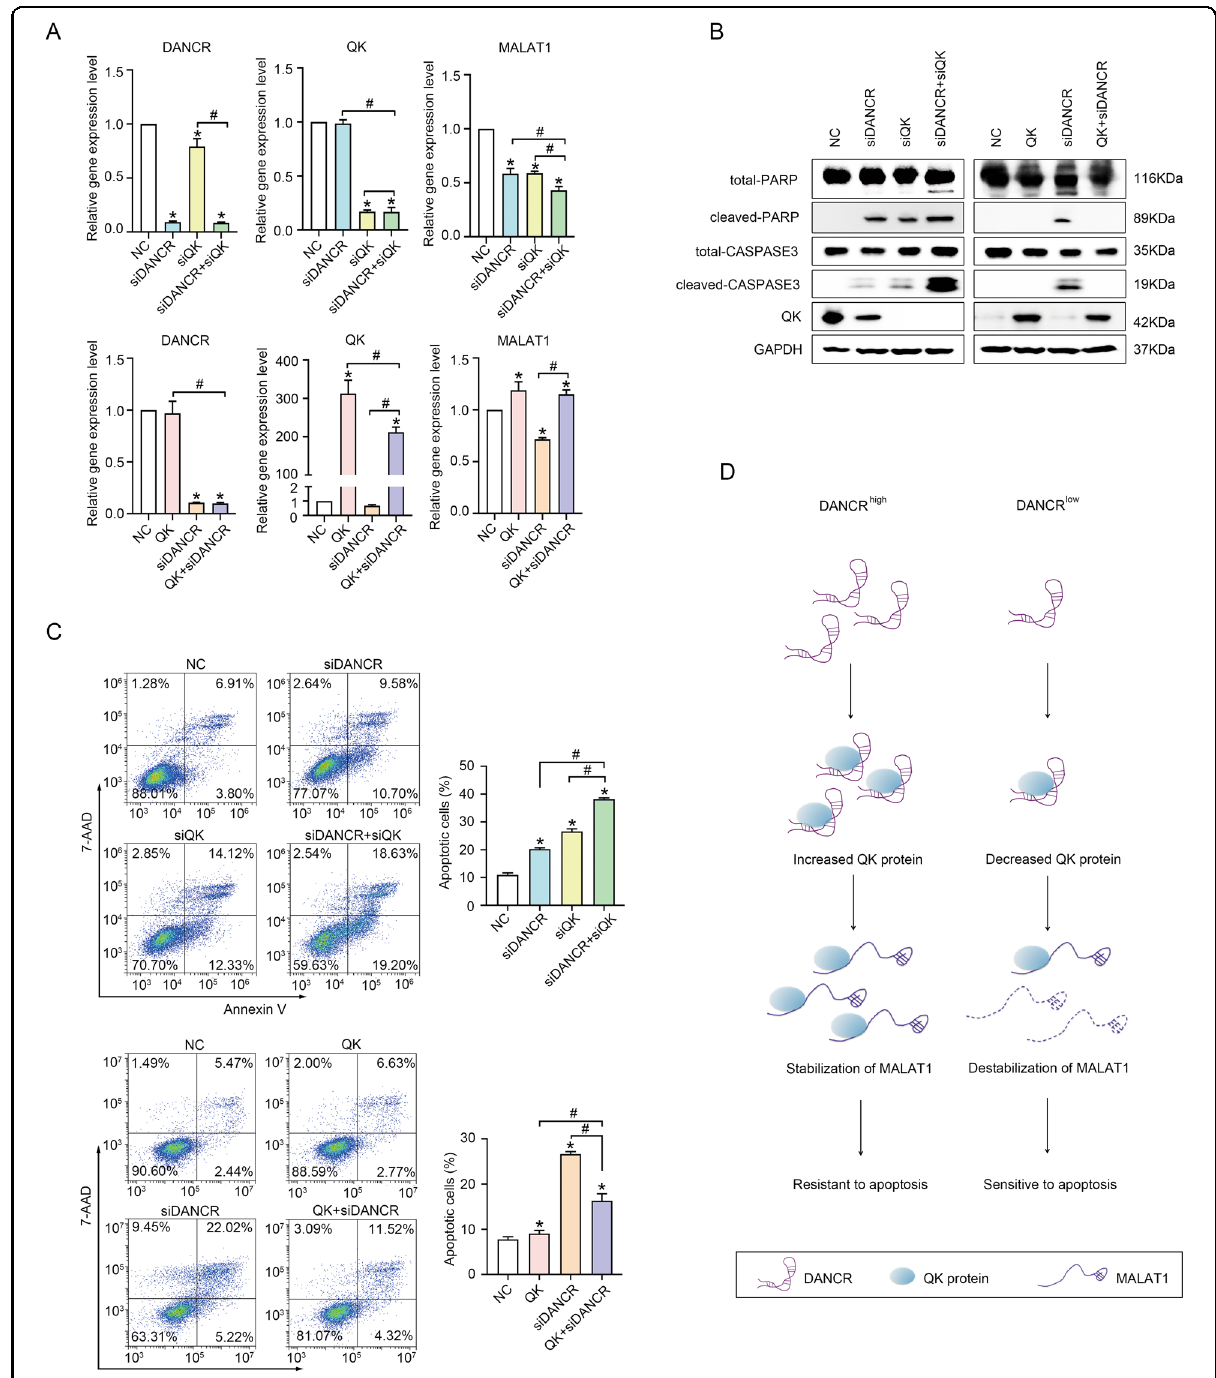
Fig. 7 QK mediated the function of DANCR on regulating MALAT1 expression and suppressing apoptosis. A The expression of MALAT1 upon DANCR knockdown combined with siQK (upper panel), or with QK overexpression (lower panel) respectively, was detected by qRT-PCR in HCT116 cells. NC, negative control. *and #, p < 0.05. B Western blotting detected QK depletion further increased (left panel), while QK overexpression inhibited (right panel), the expression of cleaved PARP and cleaved CASPASE 3 induced by DANCR silencing in HCT116 cells. C QK depletion (upper panel) and QK overexpression (lower panel) further aggravated or alleviated siDANCR-induced apoptosis, which was detected with Annexin V fl ow cytometry assay in HCT116 cells. Representative images and statistical analysis were shown. *and #, p < 0.05. D A schematic diagram for the mechanism of apoptosis regulation by the DANCR/QK/MALAT1 axis in colorectal cancer